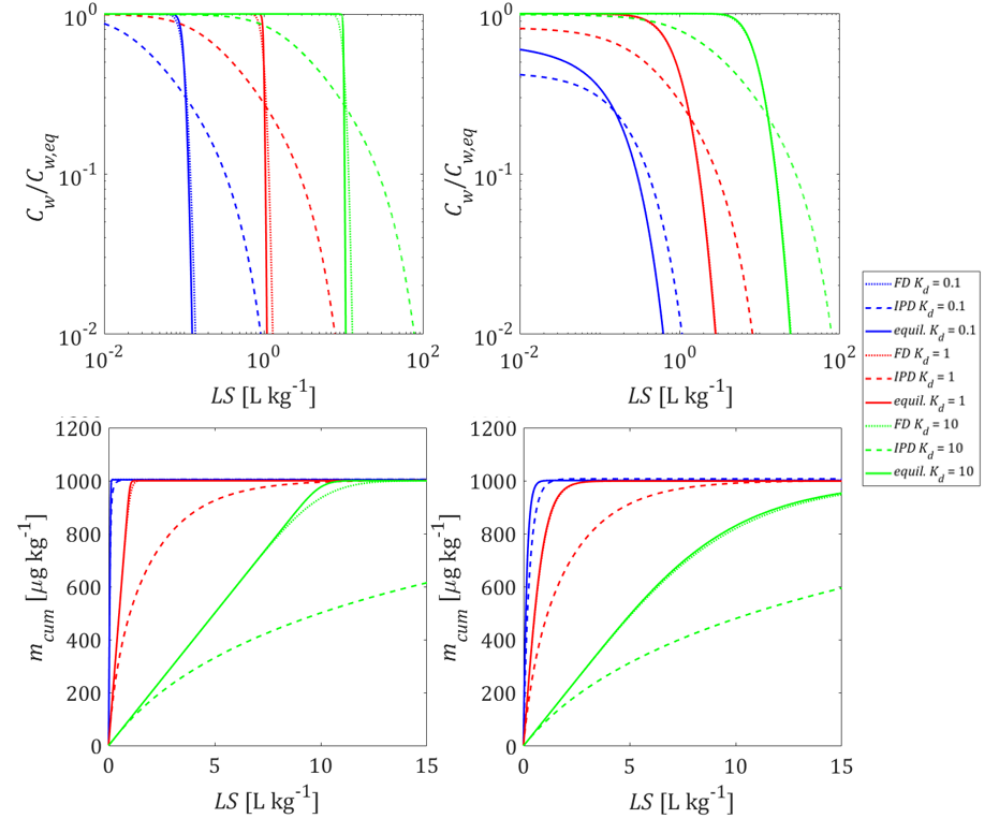
Figure 7. Normalized concentrations ( C w / C w , eq ) as well as cumulative concentrations ( m cum ) in the column effluent vs. time (expressed as liquid to solid ratio: LS ) for different mass-transfer processes, given the initial conditions depicted in Figure 6. Left column : without dispersion; Right column : with dispersion.